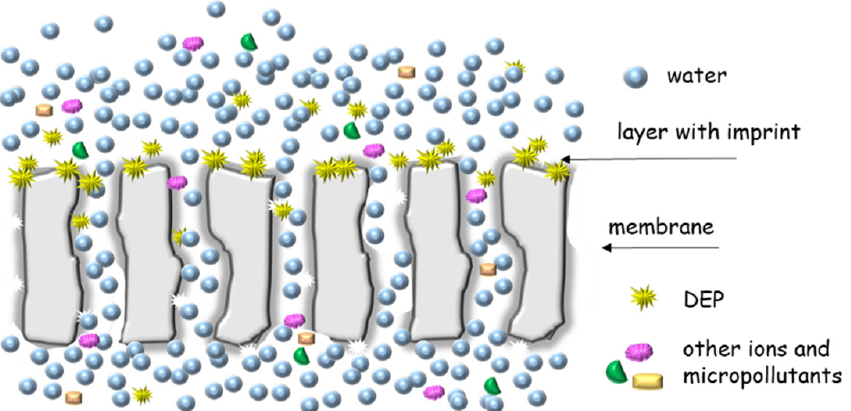
Figure 1. Scheme of molecularly imprinted membrane (MIM)operation.